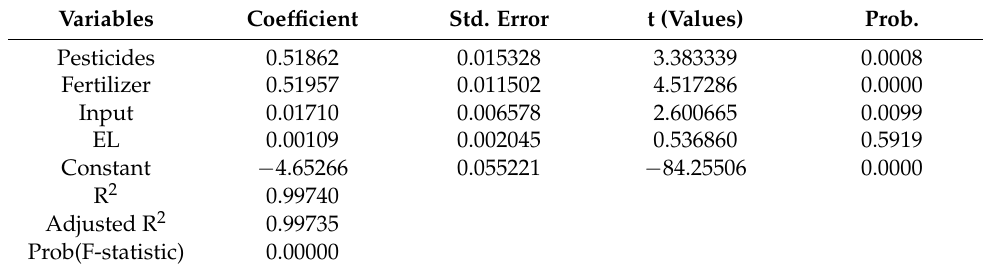
Table 4. Model for educated farmers.